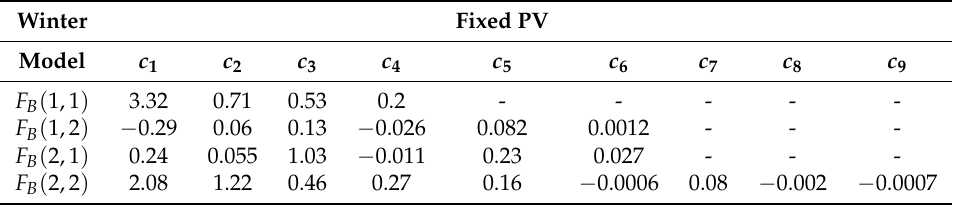
Table 4. Optimal coefficient values model B for fixed PV system.